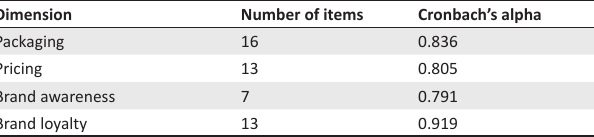
TABLE 2: Scale reliability. Dimension